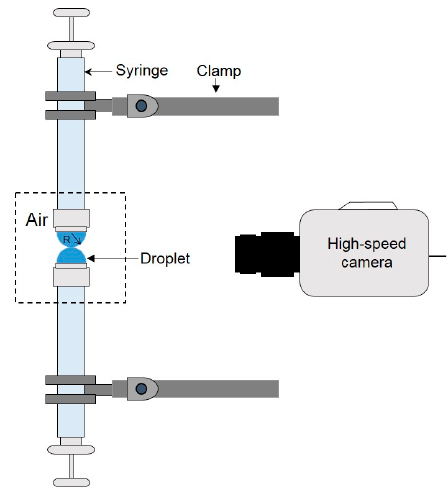
Figure 5. Schematic of the droplet coalescence experiment in air.